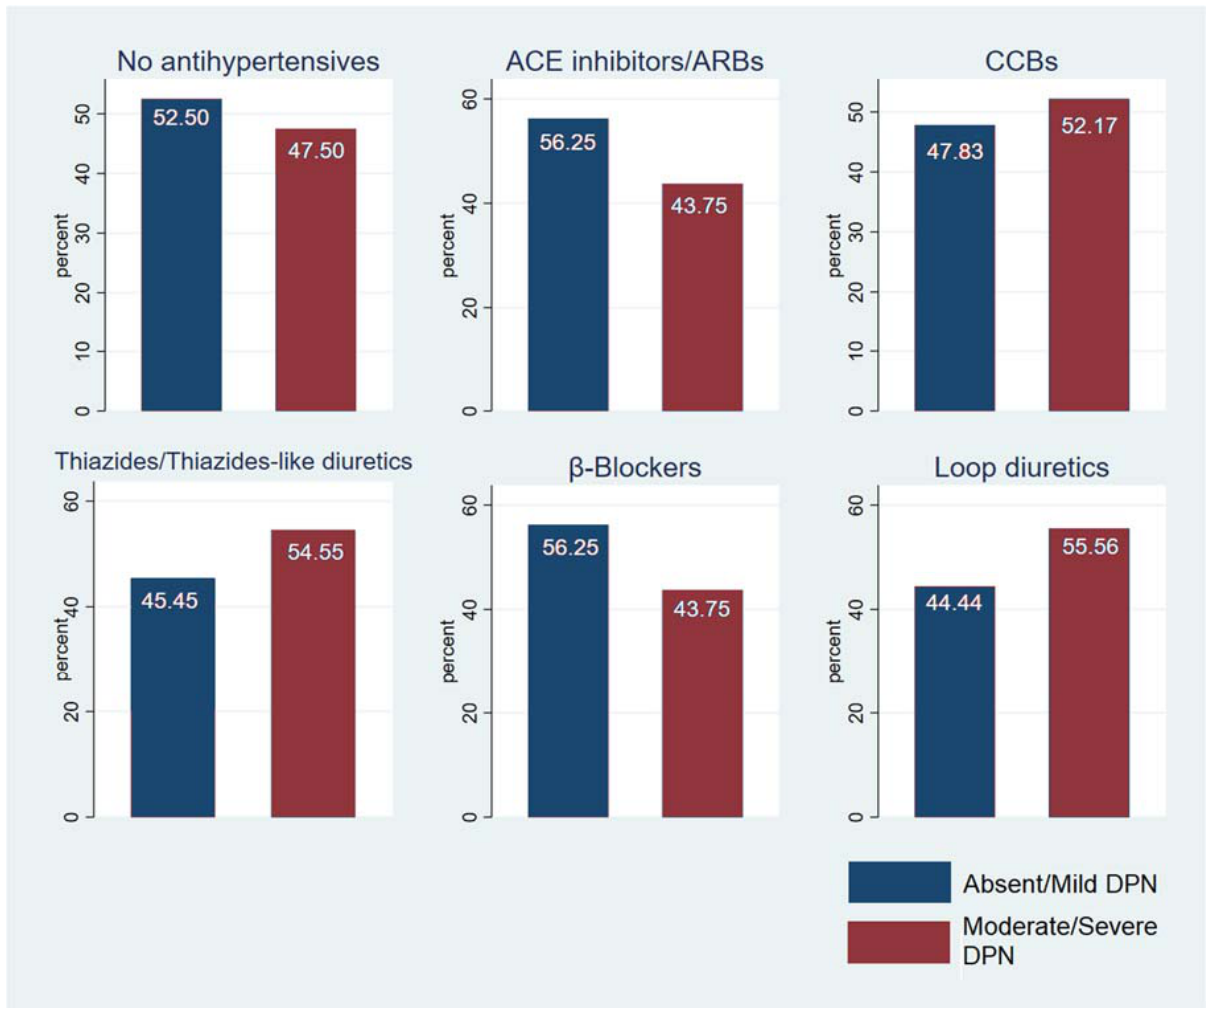
Figure 2. Schematic presentation of antihypertensive therapy and DPN status.